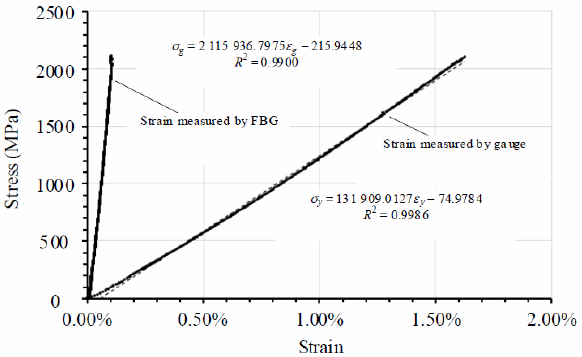
Fig. 9 Strain contrast of fiber Bragg grating and stain gauge.